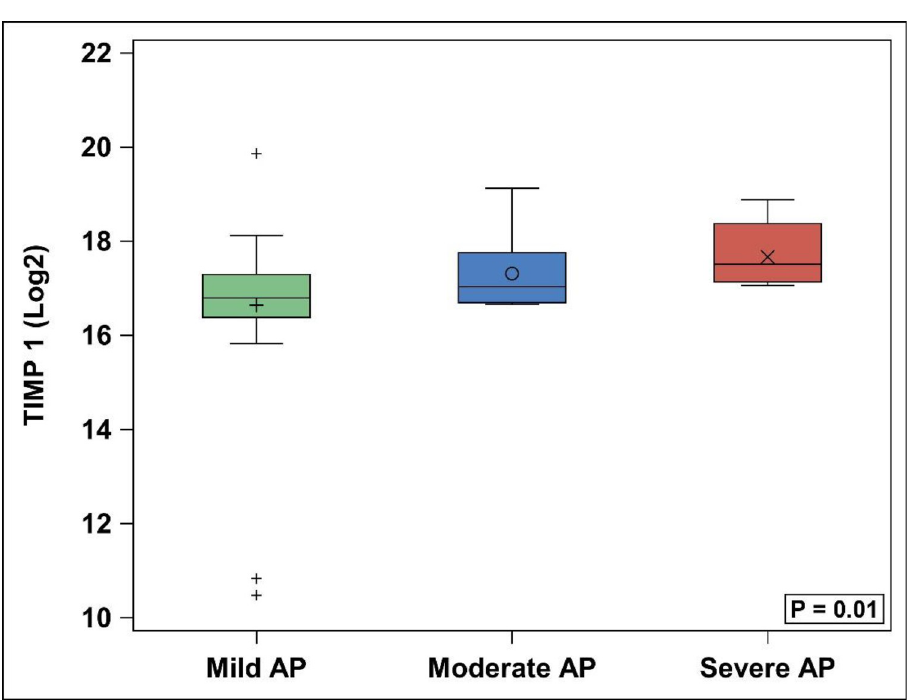
Fig 2. TIMP-1 levels. AP = acute pancreatitis. TIMP = tissue inhibitor of matrix metalloproteinase.